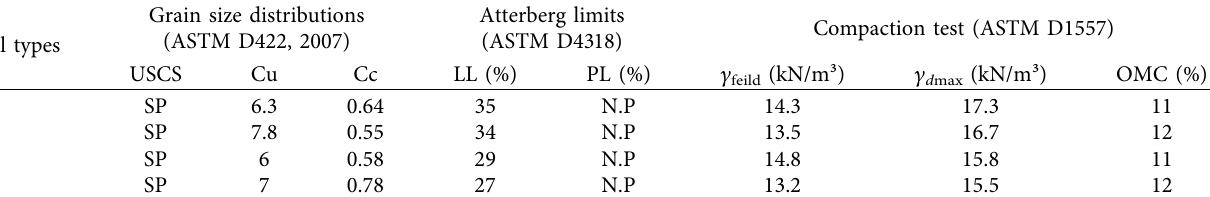
Table 2: Physical properties of soil.